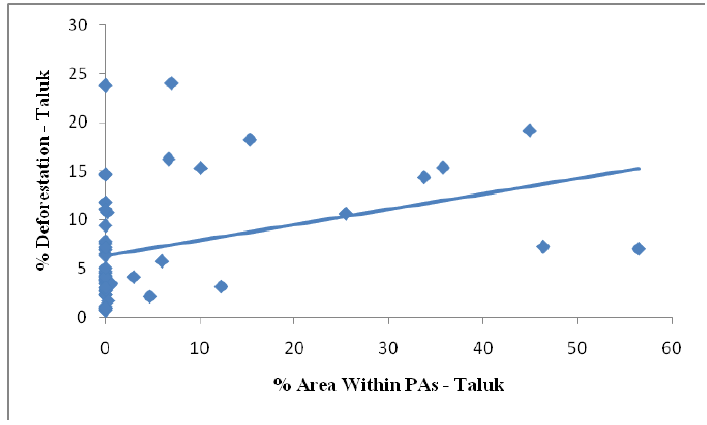
Figure 15b. Relationship between percentage of area within PAs and the distribution of deforestation for